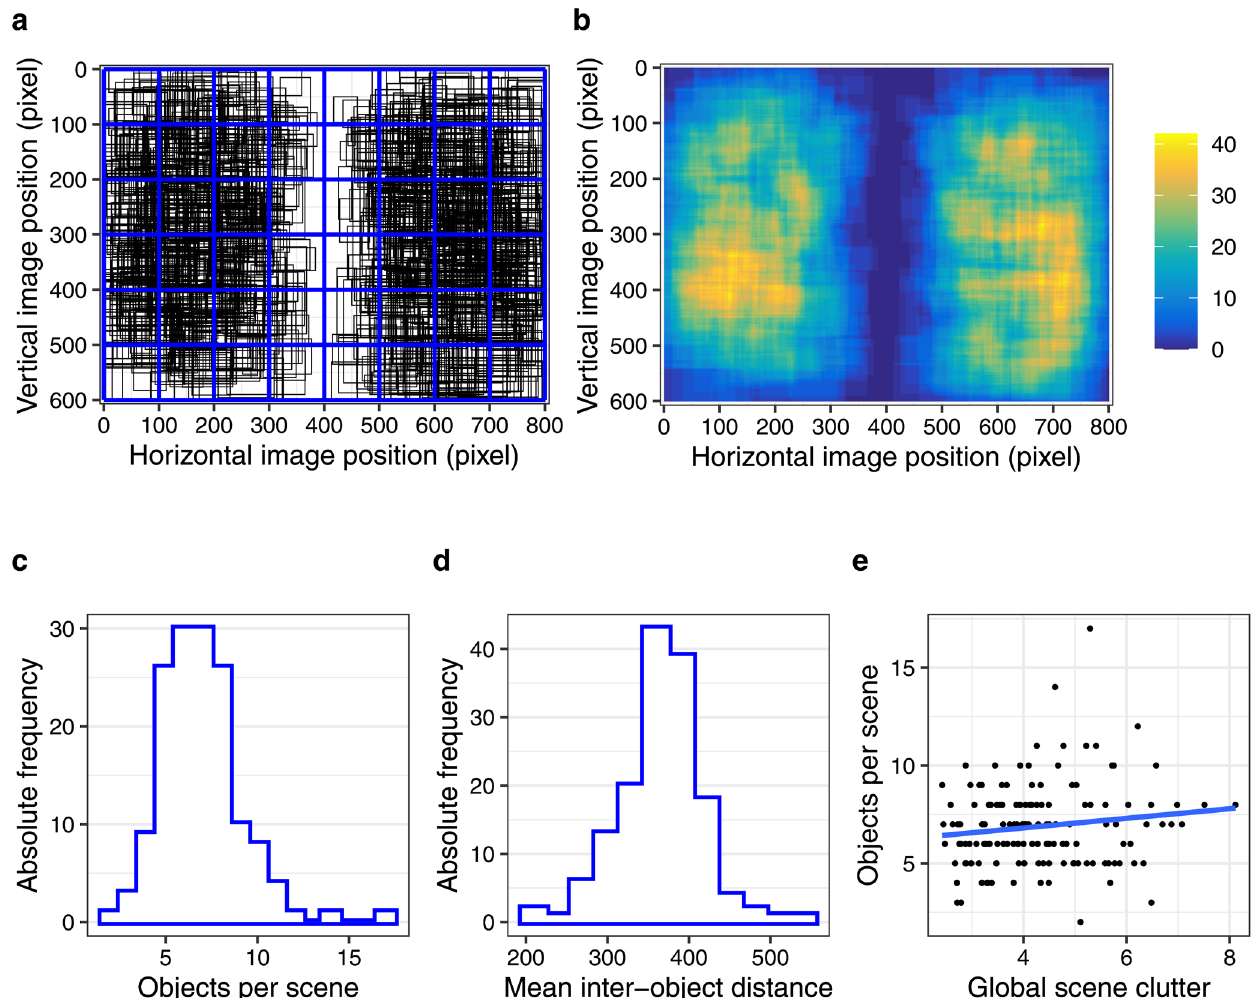
Figure 7. Objects in scenes. ( a ) Distribution and size of 1,032 object bounding boxes (black) across 150 scene images, with the scene grid (blue) overlaid as reference. ( b ) Pixel-based object map representing the distribution of all annotated objects across all scenes. ( c ) Histogram of the number of objects per scene. ( d ) Histogram of the mean inter-object distances per scene. ( e ) Scatter plot depicting the relationship between the number of annotated objects in a scene and the clutter associated with the scene; a linear regression line is added in blue. See text for inter-object distance (Fig. 7d). For most images, the mean distances are of the order of 300 to 400 pixels, which indicates a fairly homogeneous spread of the annotated objects per scene. The number of annotated objects varied across scenes (Fig. 7c); on average, there were 6.9 objects per scene ( SD = 2.1). We did not aim at an exhaustive object annotation. To approximate the density of objects in the scene, we used the Feature Congestion measure of visual clutter 89 . For each image, a scalar representing the clutter of the entire image was computed, with larger values indicating more visual clutter. Whereas our scenes varied in clutter, there was no systematic relationship between the number of annotated objects in a scene and scene clutter (Fig. 7e). Given that the AWS map values are normalized to sum to 1, the mean salience for each scene is 1/(800 × 600). The mean salience values for the annotated objects exceed the scene mean for 753 out of 1,032 objects (73%). A one-sample t test showed that object-based mean salience was significantly larger than scene-based mean salience, t (1031) = 21.37, p < 0.001. Moreover, we determined the maximum salience value for each scene and computed how often this maximum was part of an annotated object; this was the case for 39 out of 150 scenes (26%). Overall, this agrees with results from previous studies which showed that annotators tend to label “inter- esting” objects that coincide with salient locations in the image 17,90 . It is important to note that our objects showed appreciable variability in their salience (Fig. 3c). Bounding boxes for each image were imported into GridFix and converted into binary masks, allowing for easy selection of all pixels corresponding to a bounding box in both images and salience maps. The GridFix tool- box also allows for using more fine-grained outlines of objects, such as tight object boundary polygons. When comparing the PVL for objects in scenes for annotations using polygons vs. boxes, Borji and Tanner 10 found no